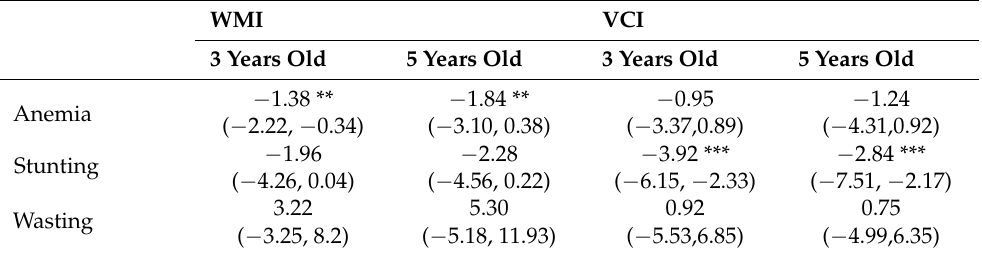
Table 4. Cross-sectional associations among anemia, stunting, wasting, and child cognitive outcomes, Values are coefficient (95% CI).